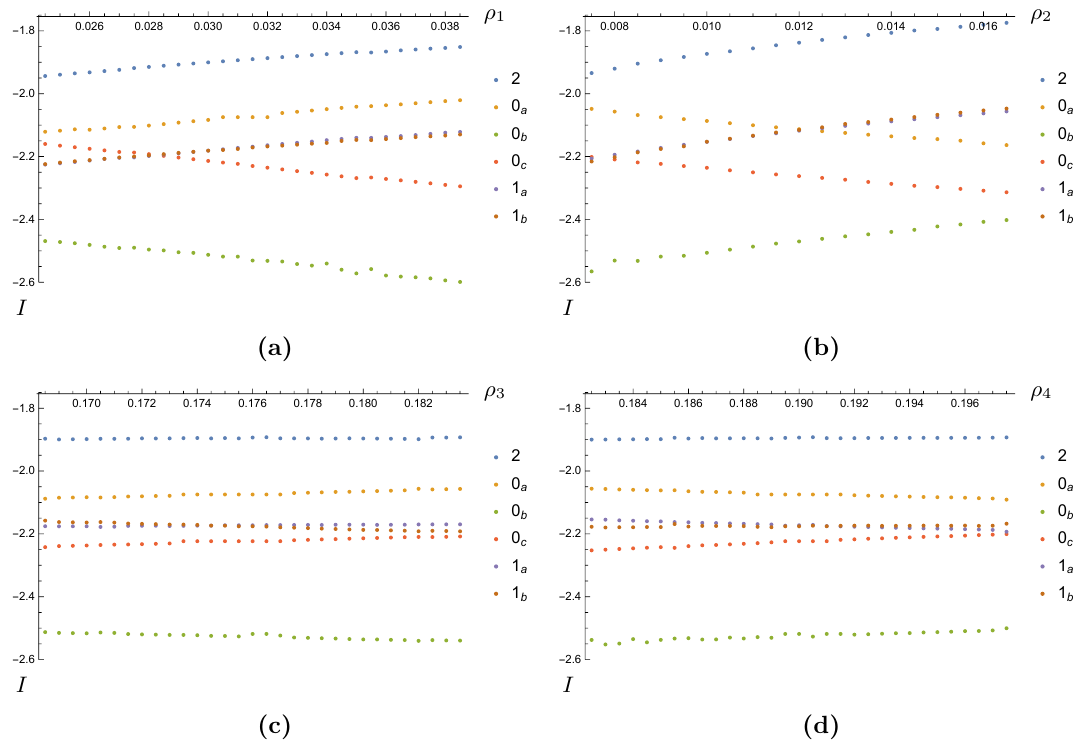
Figure 15 . The action for all six phases along four paths through the region of moduli space picked out by the coarse gradient search. Each phase is labeled by genus with a subscript corresponding to the labels in (cid:12)gures 12 and 13. The numerical errors are less than 1% in the sense of appendix A. This level of error is consistent with what may appear to be stray points along the